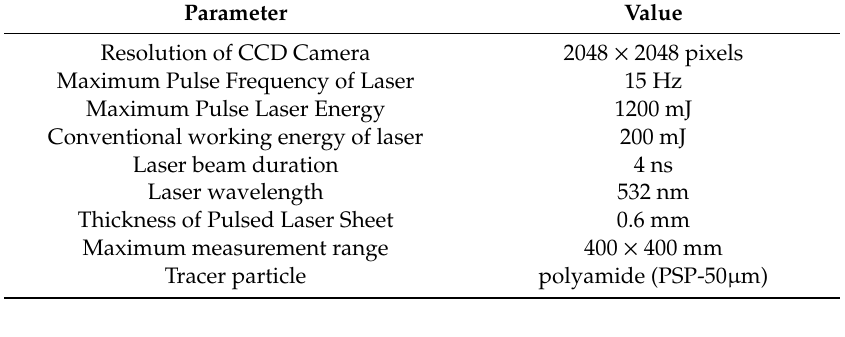
Table 2. Basic parameters of PIV. Table 1. Basic parameters of the podded propulsor.